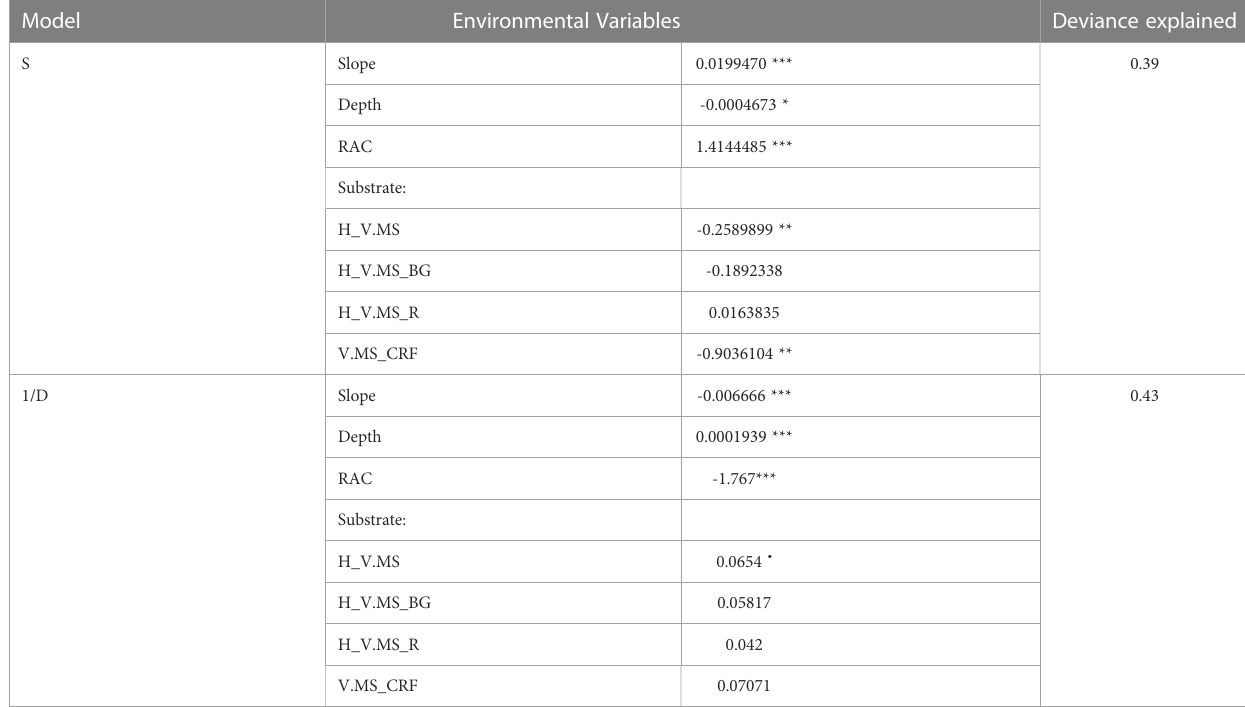
depth, M 2 amplitude, criticality of the slope and substratum type (Adjusted R 2 48%) (Figure 7 and Table 6). The fi rst axis of the RDA plot represents a gradient from reef to non-reef substrata and from supercritical to critical conditions, and the second axis represents a gradient in depth and M 2 amplitude (Figure 7). The vectors representing species scores (Figure 7) separate into three subgroups. The upper left quadrant, characterized by the predominance of the anemone Cerianthidae sp. 1, the urchin C. cidaris , the deep water oyster Neopycnodonte sp. 1, the black coral Antipathidae sp. 1, the squat lobster Munididae sp. 1, the basket star